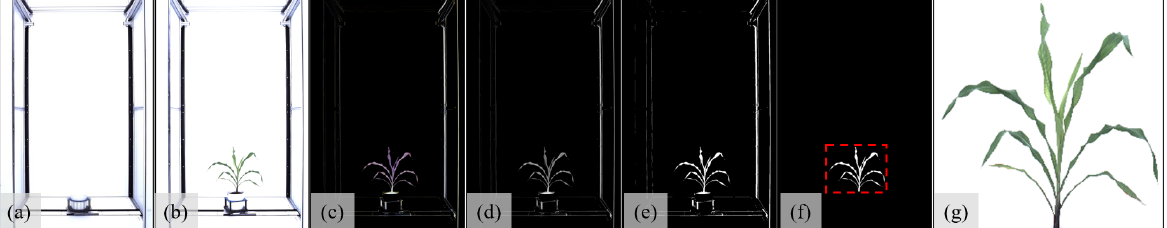
Figure 2. Image preprocessing with an example of a sorghum image: ( a ) average background image, ( b ) original image, ( c ) difference image, ( d ) difference image in gray-scale space, ( e ) binary image, ( f ) cropped binary image, and ( g ) cropped plant image from the original